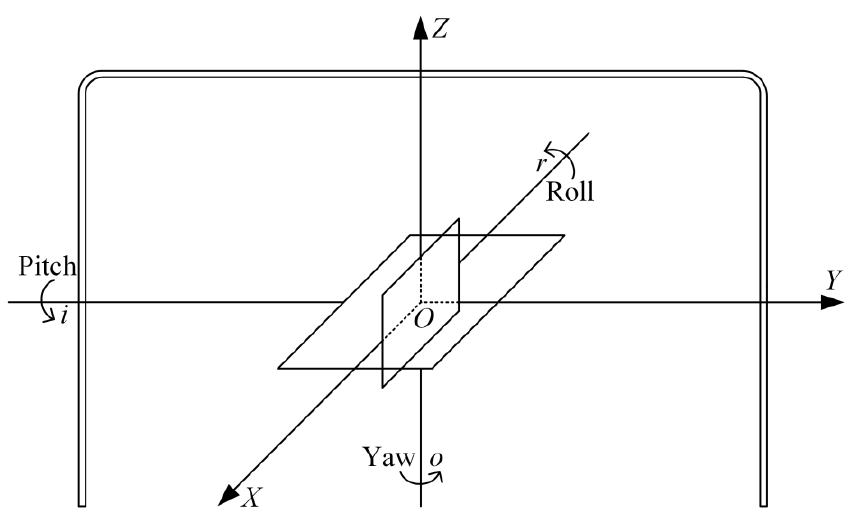
Figure 6. Coordinate relationship between the three-axis translation table and the three-axis rotary table.